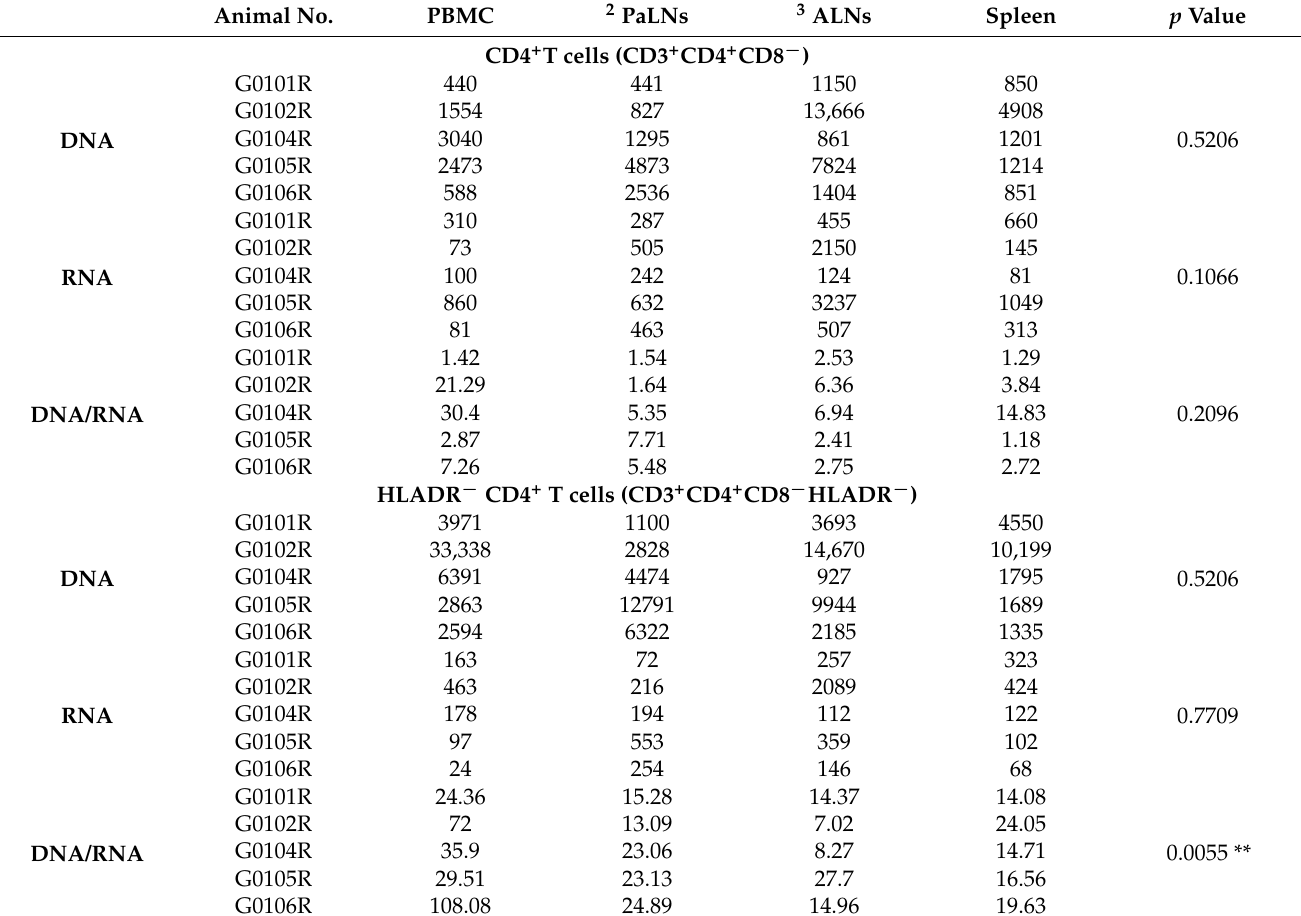
Table 1. Cellular SIV DNA, and RNA levels in CD4 + T cells and HLADR − CD4 + T cells from different organs and tissues of chronic SIV mac239 -infected macaques 1